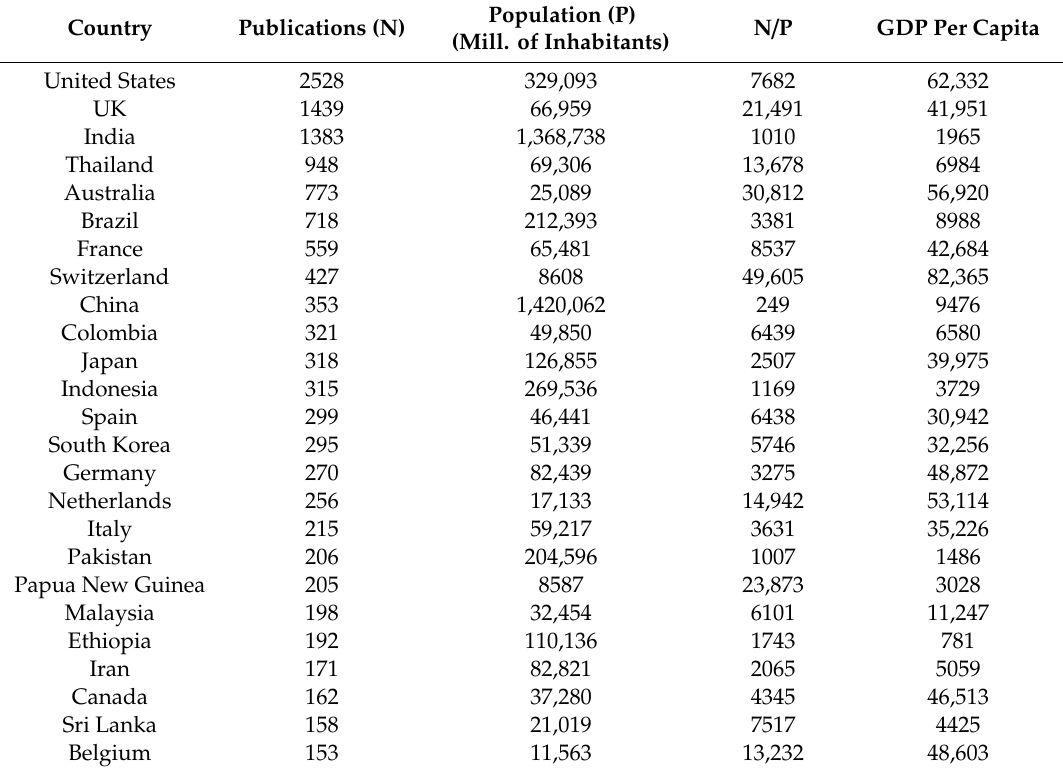
Table 1. Leading countries in terms of scientific research and publication in terms of population and wealth